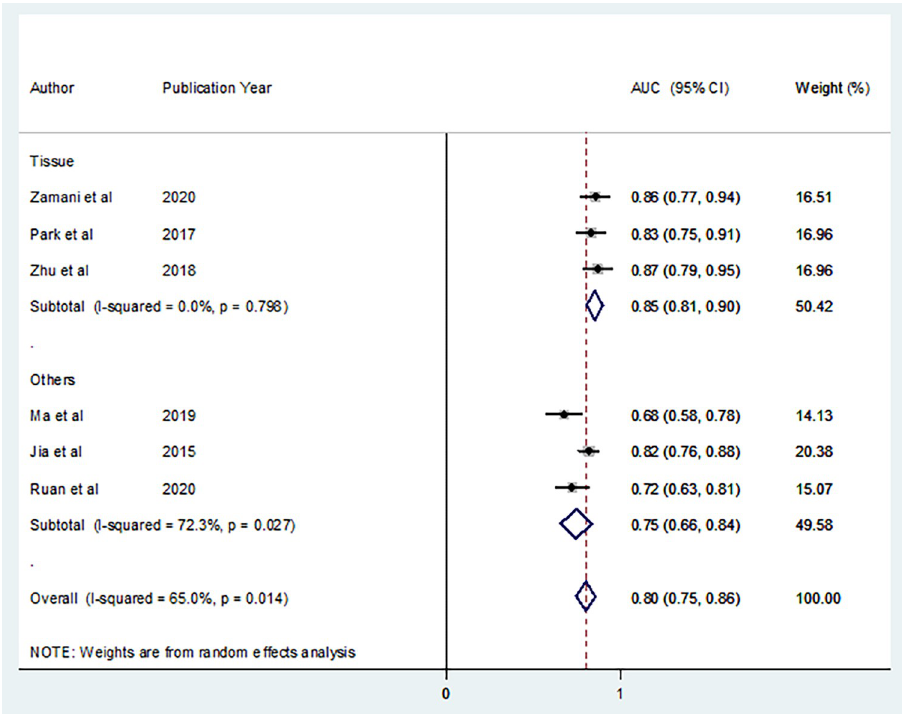
Fig 7. A forest plot showing subgroup analysis based on the sample source of microRNA-21 assay diagnostic value in cervical cancer.